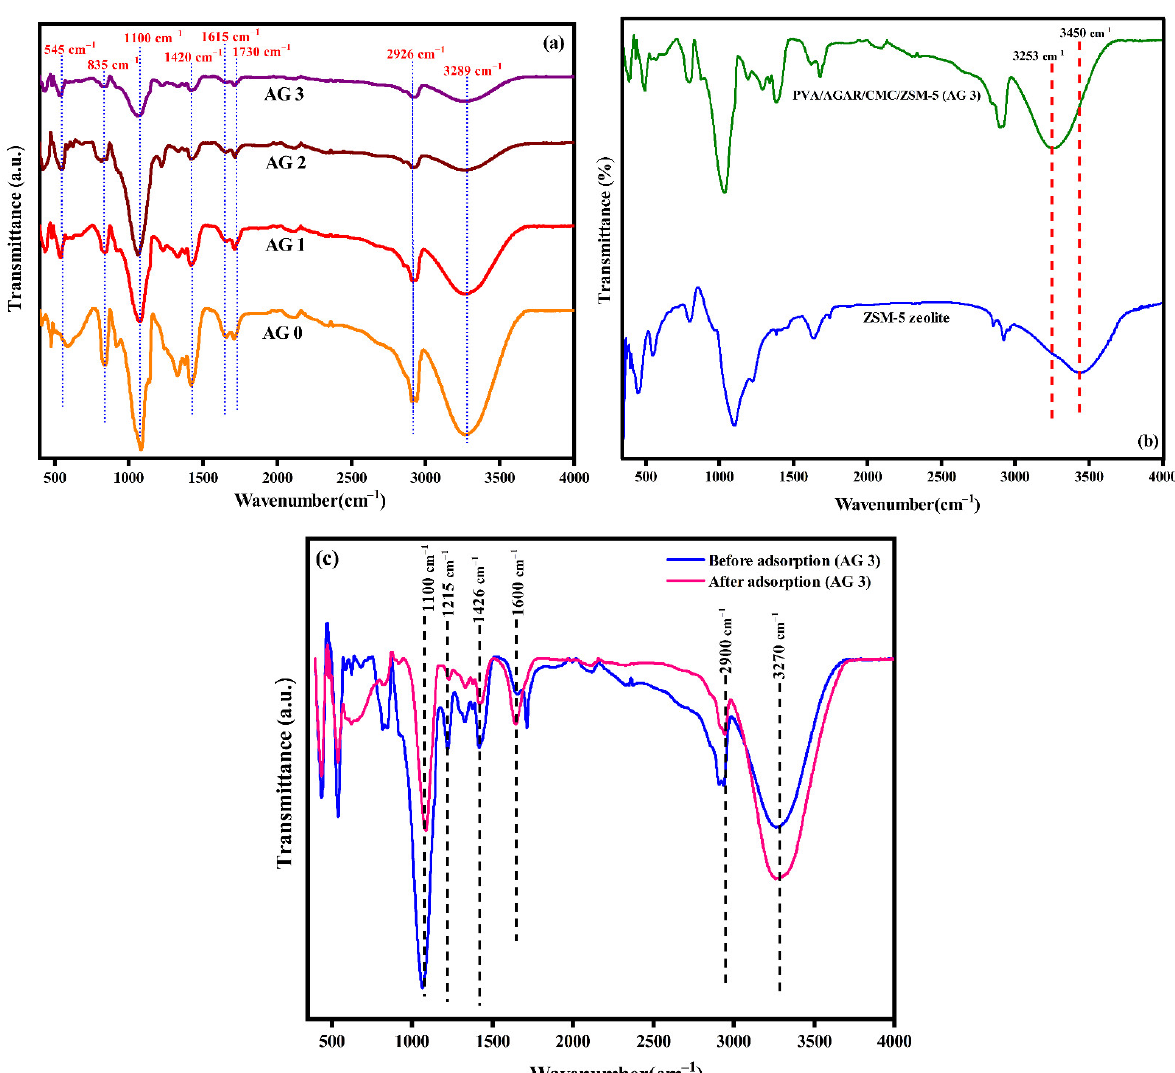
Figure 3. FTIR spectra of: ( a ) agar/CMC/PVA with different percentage of zeolite ( b ) ZSM-5 zeolite and agar/zeolite/CMC/PVA biomembrane ( c ) agar/zeolite/CMC/PVA biomembrane before and after dye adsorption.